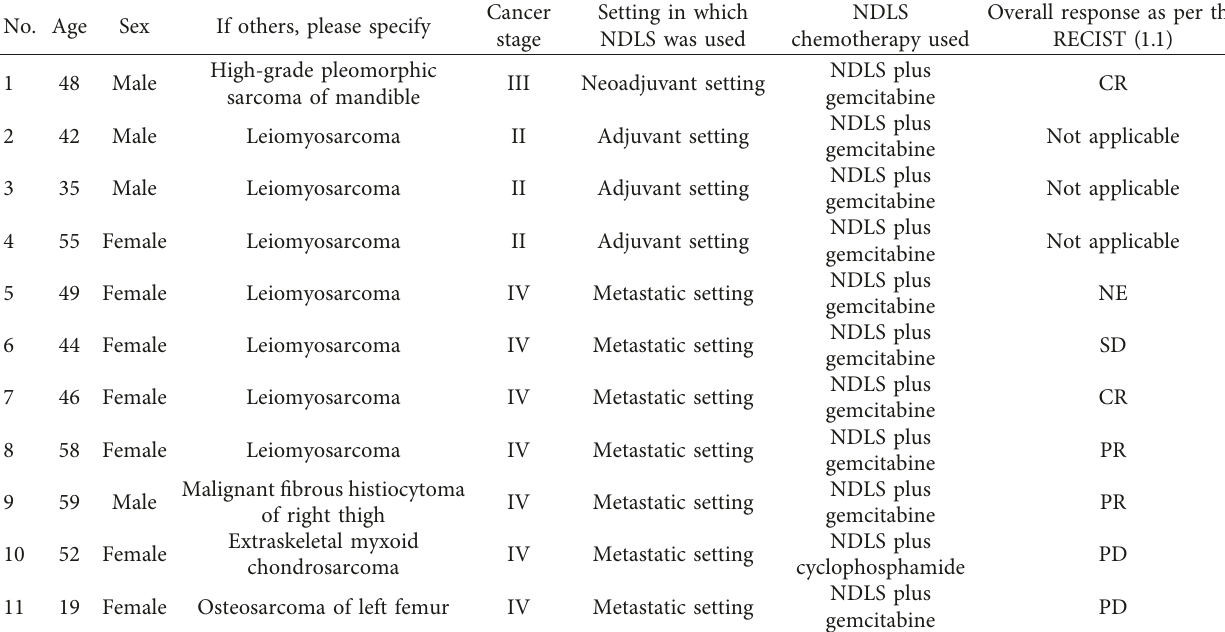
Table 2: Patient details with chemotherapy regimens and efficacy